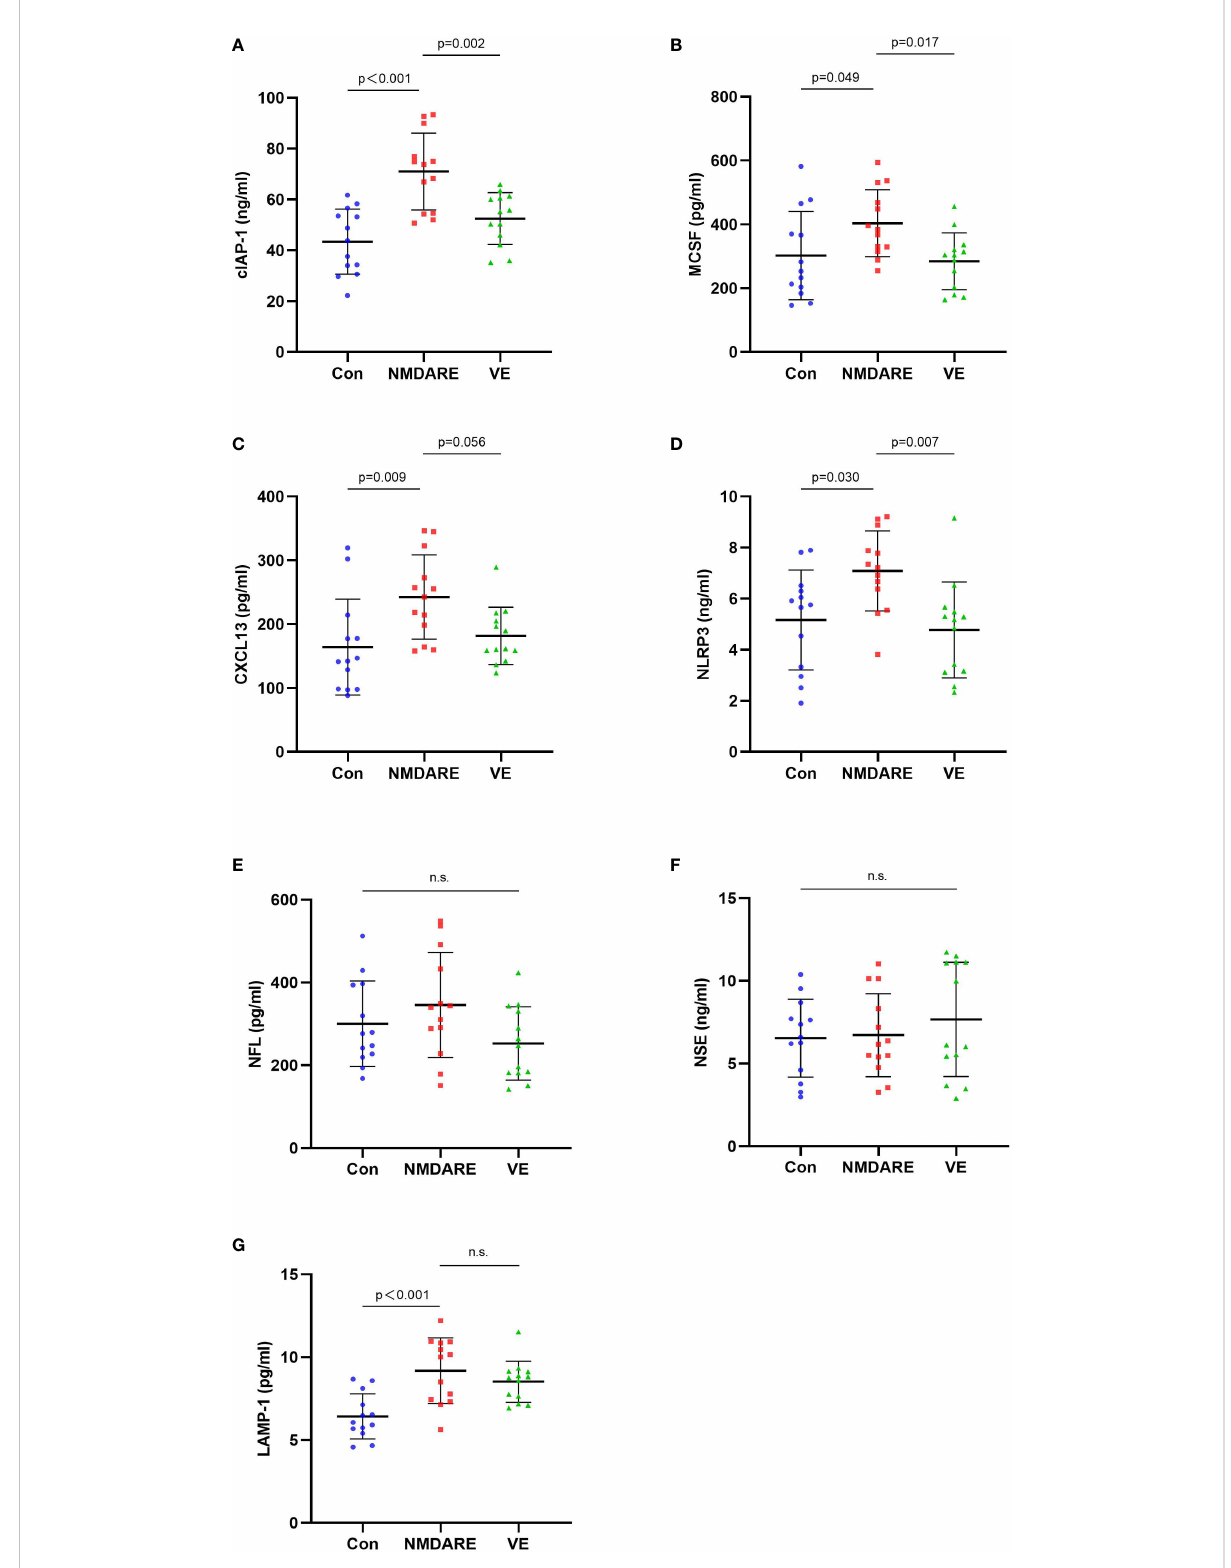
FIGURE 4 The CSF levels of cytokines and in fl ammatory mediators among the control group, anti-NMDAR encephalitis group, and viral encephalitis group in the validation cohort detected by ELISA. (A) Cellular inhibitor of apoptosis protein (cIAP-1) in CSF among the three groups. (B) Macrophage colony-stimulating factor (MCSF) in CSF among the three groups. (C) CXC chemokine ligand 13 (CXCL13) in CSF among the three groups. (D) Nucleotide binding oligomerization domain-like receptor protein 3 (NLRP3) in CSF among the three groups. (E) Neuro fi lament light chain (NFL) in CSF among the three groups. (F) Neuron-speci fi c enolase (NSE) in CSF among the three groups. ELISA, enzyme-linked immunosorbent assay. Data are expressed as mean ±SD. p -value: One-way ANOVA. n =13/group. n.s. indicates no signi fi cant differences among the groups. (G) Lysosome-associated membrane protein 1 (LAMP-1) in CSF among the three